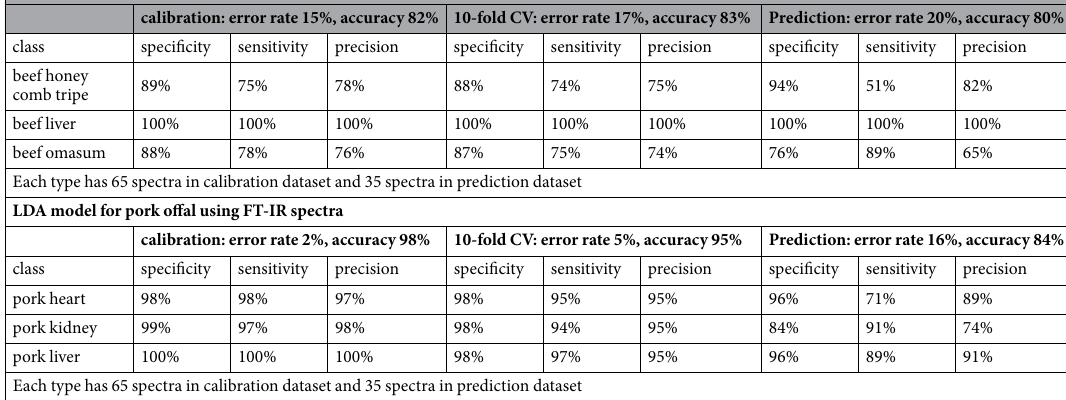
Table 3. The optimized models for the 3-class classification of beef and pork offal using FT-IR spectra.